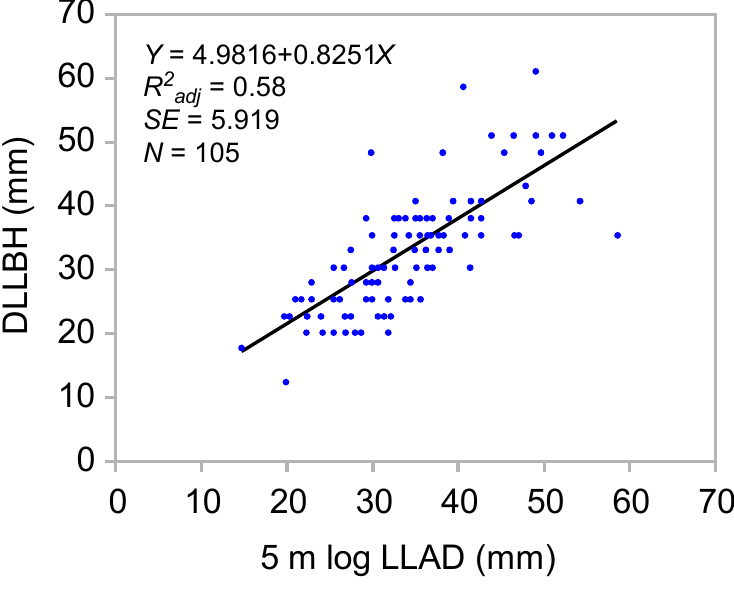
Figure 7. Relationship between largest limb average diameter (LLAD) of the 5-m butt log and diameter of the largest limb at breast height for the same tree (DLLBH) on plots from the Stand Management Cooperative Twin Peaks field trial (adapted from